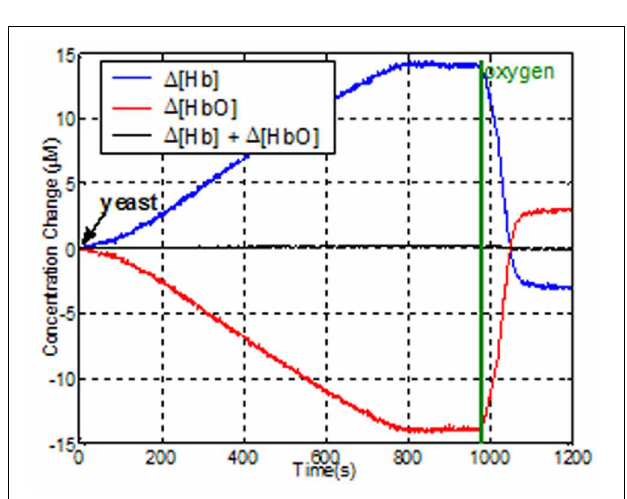
FIGURE 15 | Effects of de- and re-oxygenation during blood test on liquid phantom as measured by the wireless fNIRS